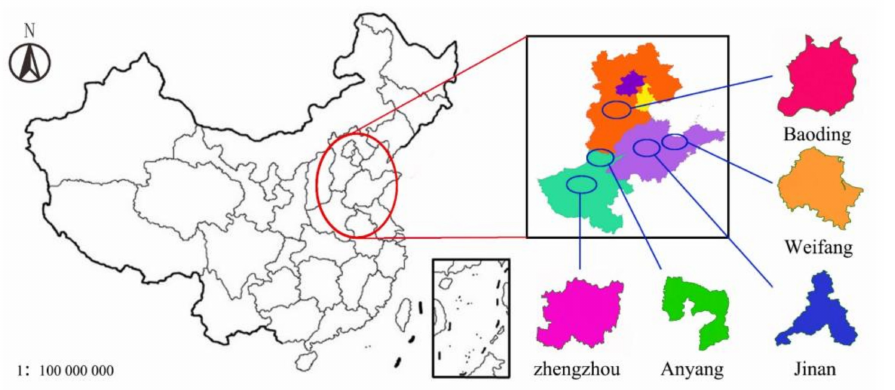
Figure 1. Geographical location of five cities in